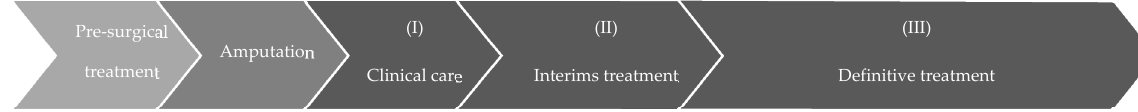
Figure 1. The amputation and prosthetic treatment process including three major phases as regards the German context: (I) clinical care, about two to four weeks; (II) interim treatment, about three to six months; (III) definitive treatment, long-term.